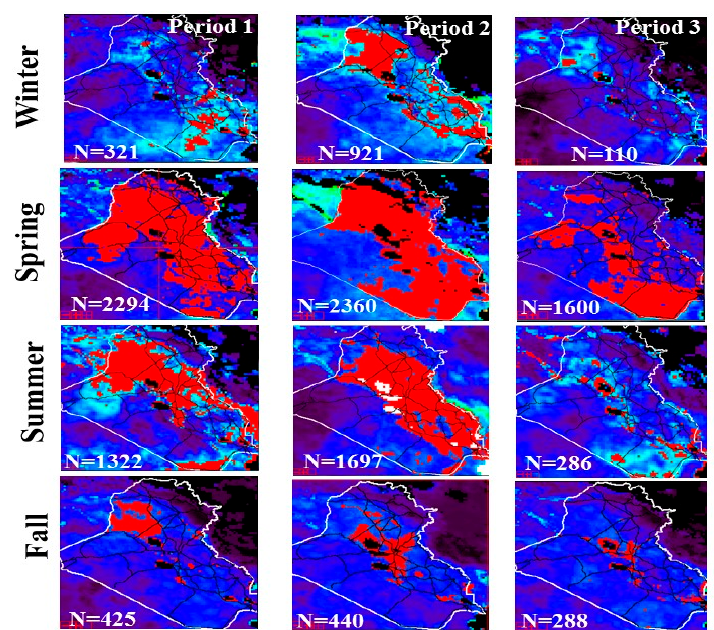
Figure 7. Standard deviation (stdev) of AOD during the three time periods (see legend in Figure 6). Highlighted in red are all pixels with stdev above 0.15. All pixels were counted and are shown.